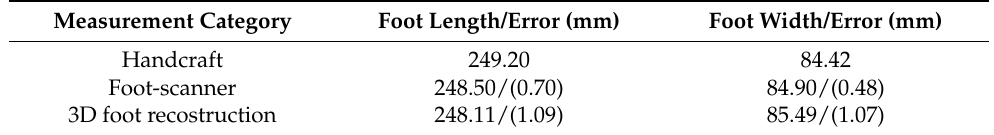
Table 1. The results of different